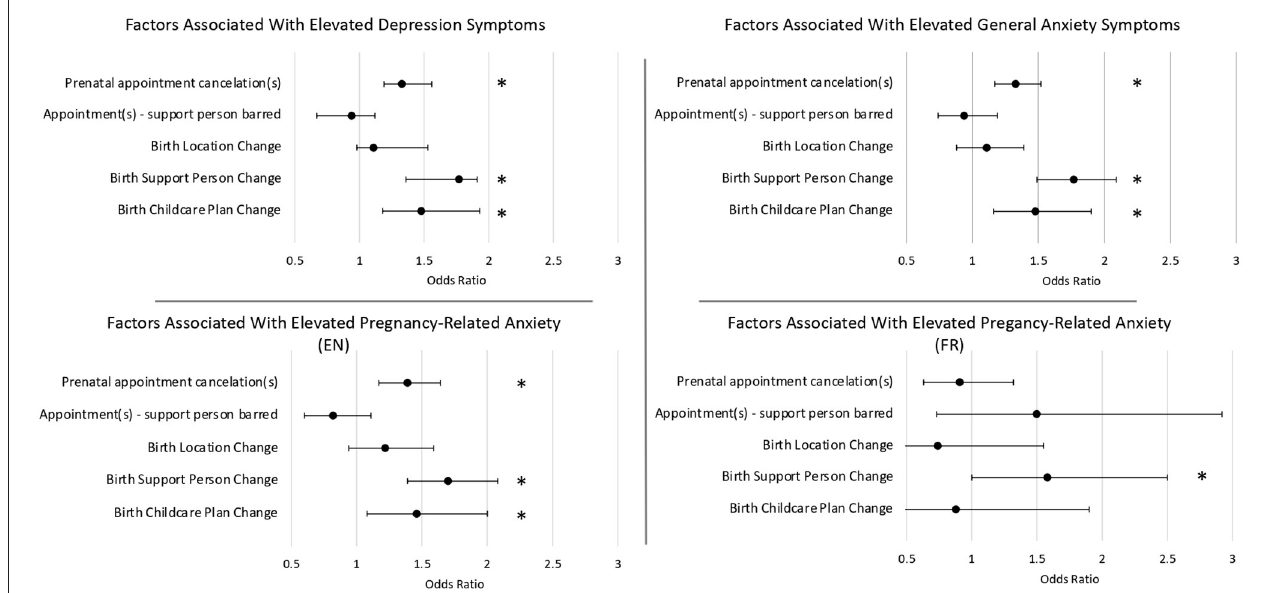
FIGURE 2 | These odds ratios demonstrate how each of the COVID-related disruptions to prenatal care affects the odds of experiencing elevated symptoms of psychological distress. Odds ratios were adjusted for age, parity, ethnicity, trimester, maternal education, and household income. Note that the sample size for the French Pregnancy-Related Anxiety Questionnaire (PRAQ-R2) was smaller than for the English PRAQ. *Indicates statistical significance ( p <